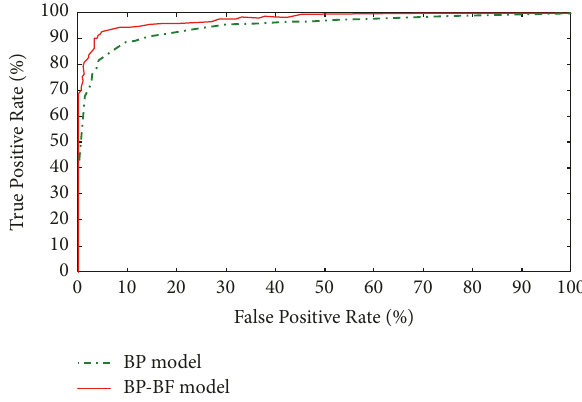
Figure 11: ROC curve of the identification